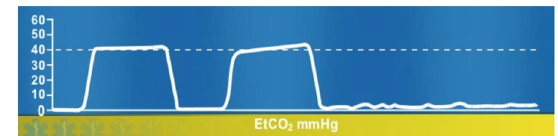
Fig. 4 Normal capnogram waveform performed in this study